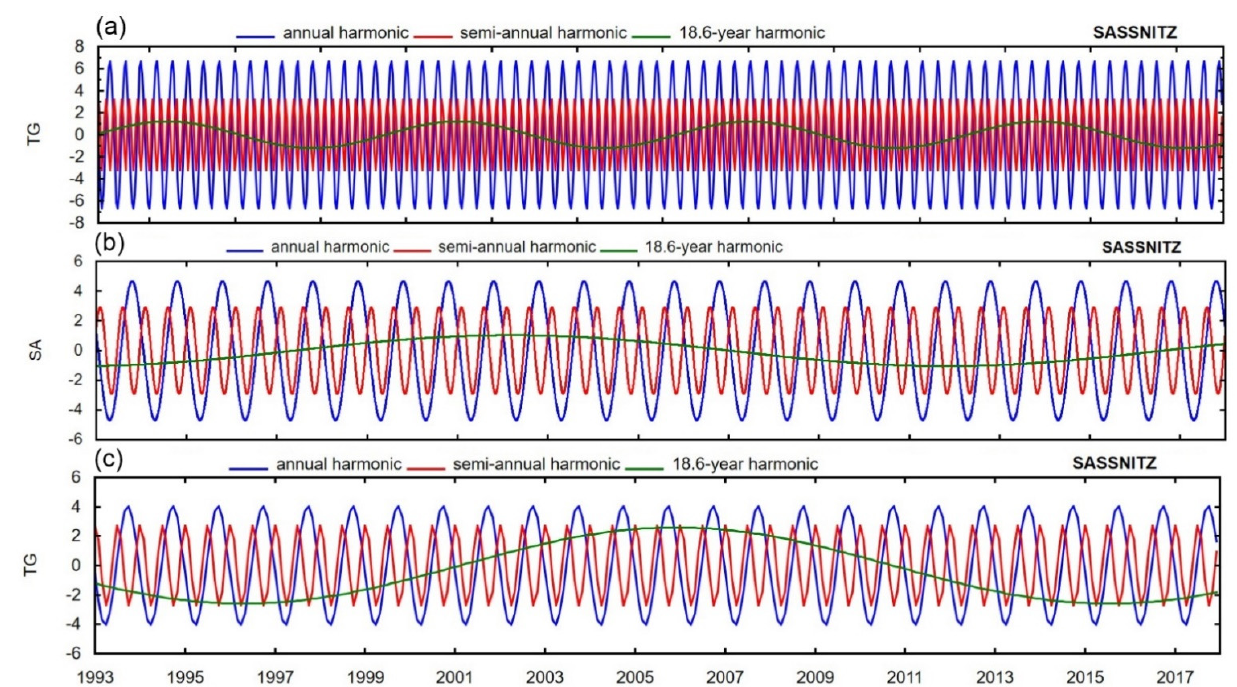
Figure 3. ( a ) Annual, semiannual and 18.61-year harmonics functions based on TG data for 1946 – 2017. ( b ) Annual, semiannual and 18.61-year harmonics functions based on SA data for 1993 – 2017. ( c ) Annual, semiannual and 18.61-year harmonics functions based on TG data for 1993 – 2017 in the Sassnitz station. The units are in centimetres.